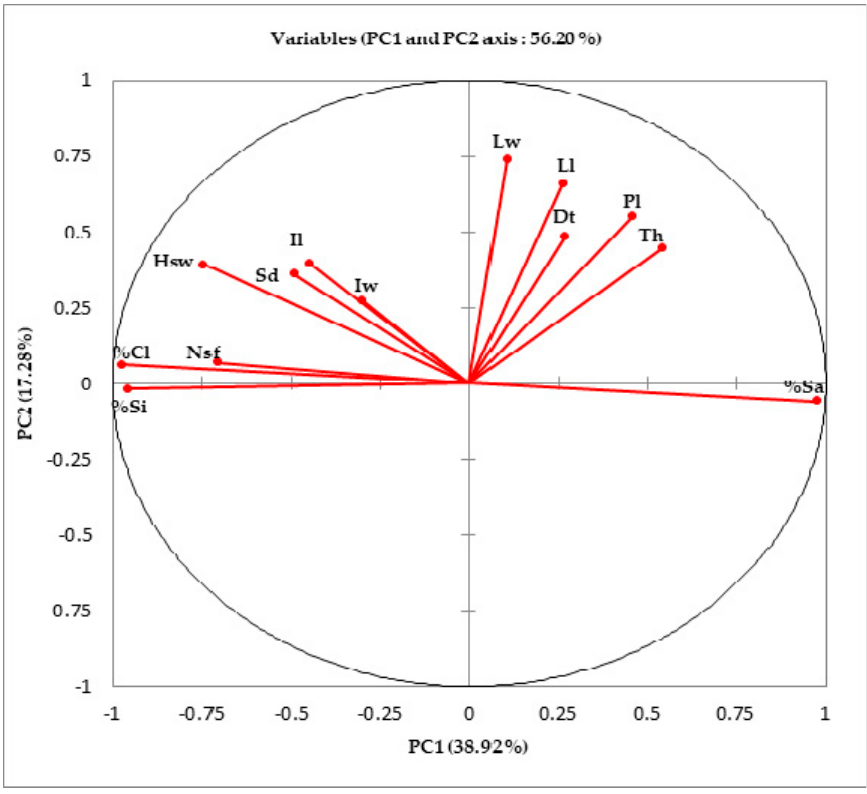
Figure 5. Principal Component Analysis based on plant morphology and soil physical traits